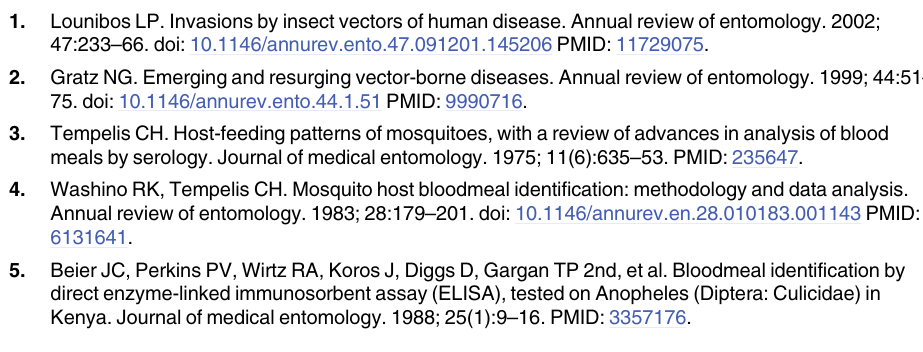
DNA sequence. The tree shows the entire range of species amplified and colored by classes (Blue, mammals; Red, bony-fish; Green, amphibians). S4 Fig. Box plot showing the number of sequencing reads generated per mosquito accord- ing to the blood meal status of mosquitoes determined visually (only samples from one sequencing run are displayed). S5 Fig. Neighbor-joining phylogenetic tree showing the species relationships among bat species based on the DNA sequence targeted with the 16S mt rRNA primers. The two bat DNA sequences amplified from one mosquito ’ s blood meal are shown by the red boxes. S6 Fig. Neighbor-joining phylogenetic tree showing the relationships among marsupial genera based on the DNA sequence targeted with the 16S rRNA mt primers. The marsupial DNA sequence amplified from one mosquito ’ s blood meal is shown in the red box. S7 Fig. Neighbor-joining tree showing the relationships among human DNA sequences amplified using the mt hypervariable primers. The shapes indicate the species of each mos- quito carrying a specific human DNA sequence (squares represent An . punctulatus s . s ., trian- gles An . farauti 4). The color of each shape indicates the village where the mosquito was collected (green from Dimer, blue from Wasab, and purple from Kokofine). Note the long- branch separating the mitochondrial DNA sequences from the nuclear insertion (numt)